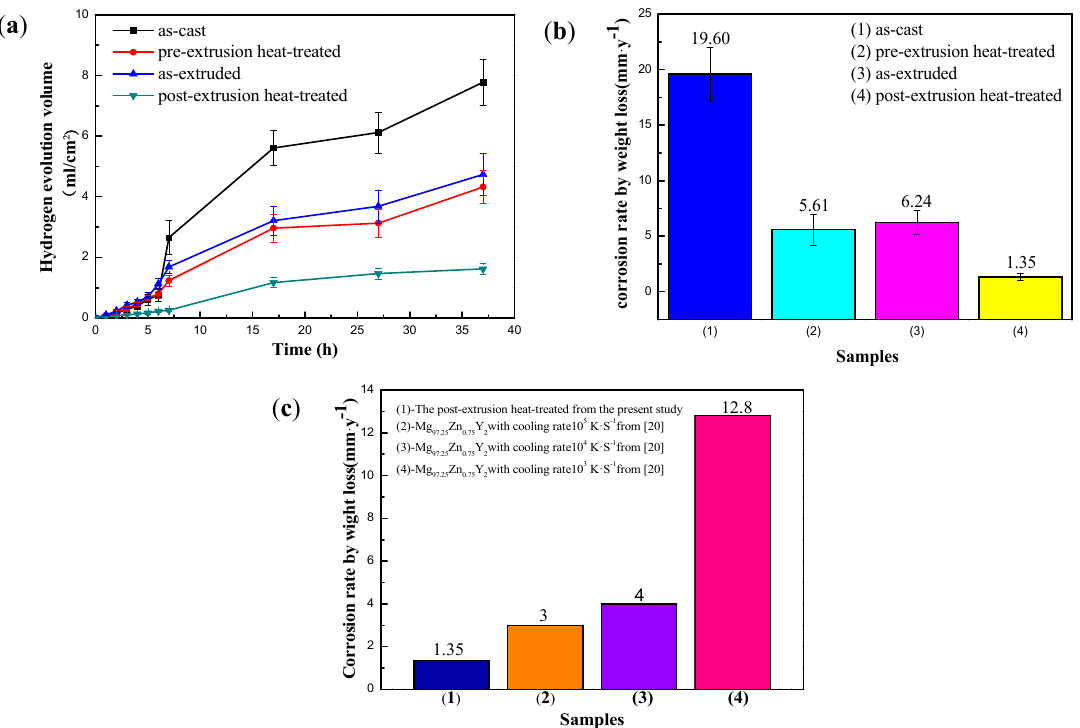
Figure 6. Hydrogen evolution curves for 37 h ( a ) weight-loss corrosion rate for 98 h; ( b ) of Mg 95.33 Zn 2 Y 2.67 alloy by immersing in 3.5 wt % NaCl solution; ( c ) corrosion rate of the post-extrusion heat-treated alloy with other alloys reported [27].